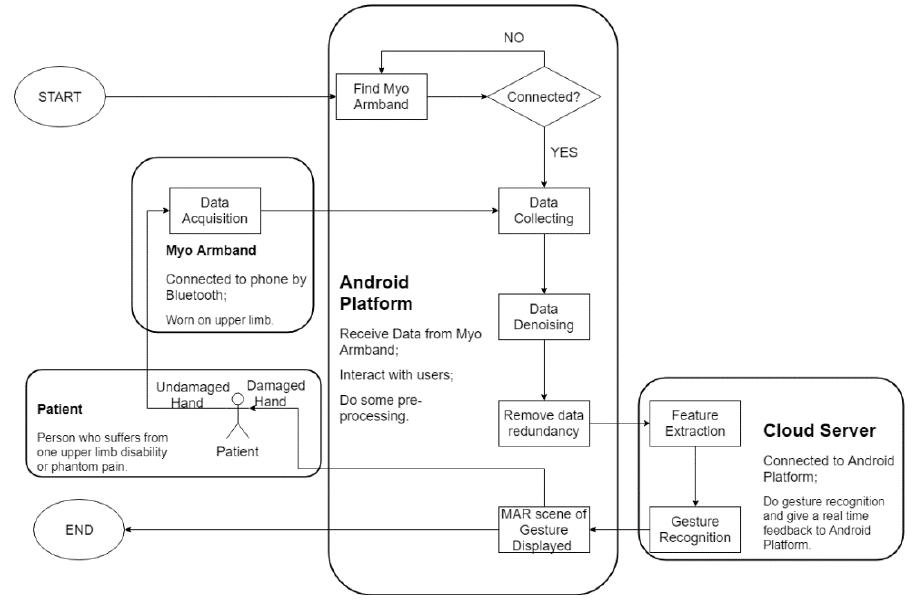
Figure 11. The mirror therapy system diagram.